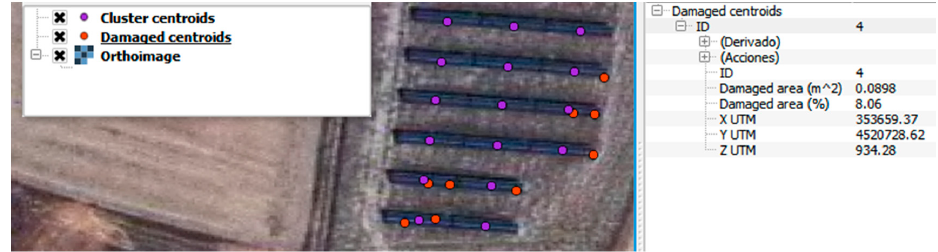
Figure 10. Result of the proposed methodology integrated with aerial orthophotography from a WMS (Web Map Service) using a GIS (Geographic Information System) client.